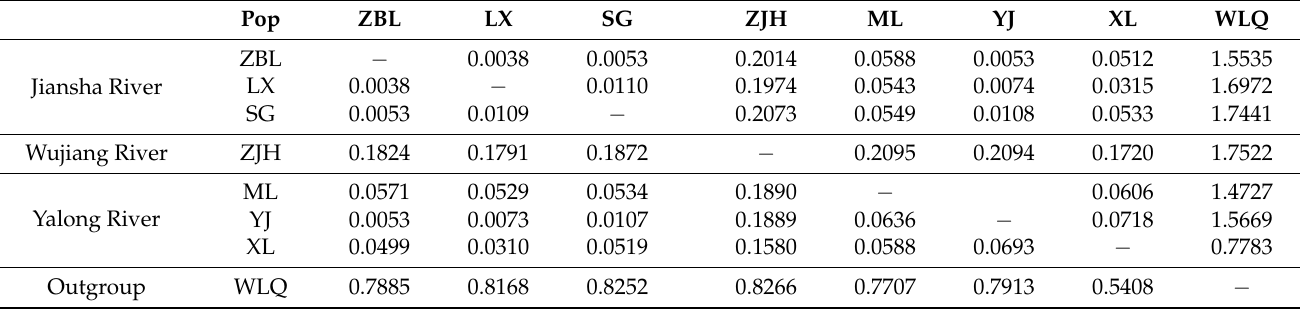
Table 3. Genetic distance within and between S. kozlovi populations (above diagonal) and genetic fixation index ( F st ) (below diagonal) of